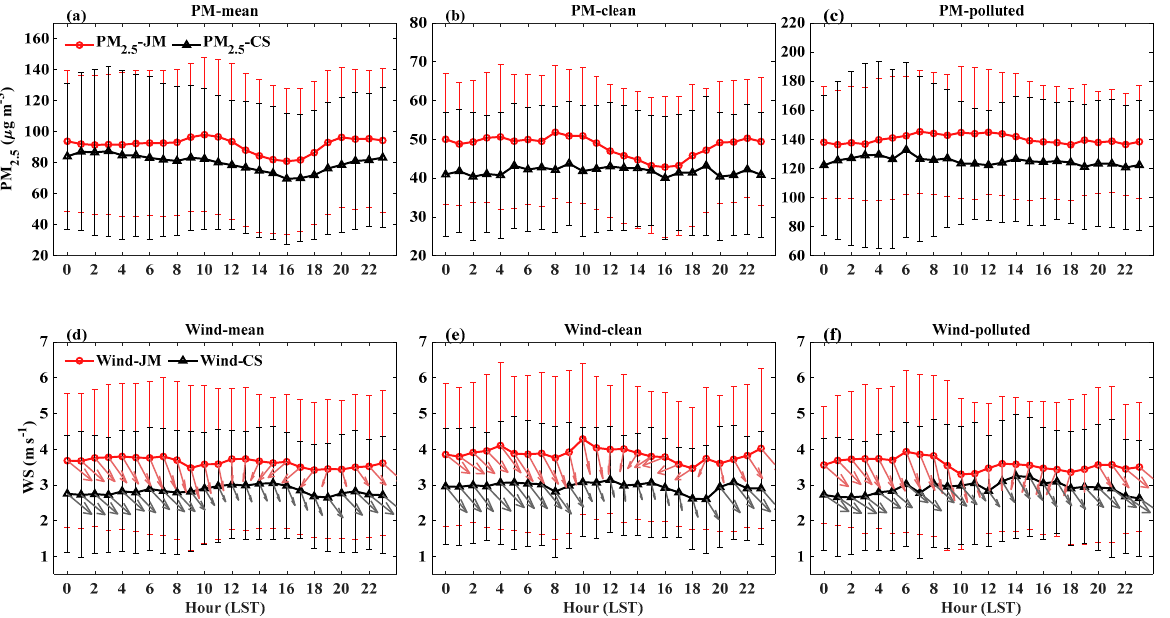
Figure 2. Diurnal cycles of the surface ( a – c ) PM 2.5 concentrations and ( d – f ) wind field under clean and polluted conditions in CS and JM for winters from 2016–2020. Error bars denote standard devi- ations. Table 2. Averaged PM 2.5 concentrations and wind speed (expressed as mean ± standard deviation), as well as their correlation coefficients under clean and polluted conditions in JM and CS for winters from 2016–2020. Averaged PM 2.5 Concentrations ( μ g m –3 )